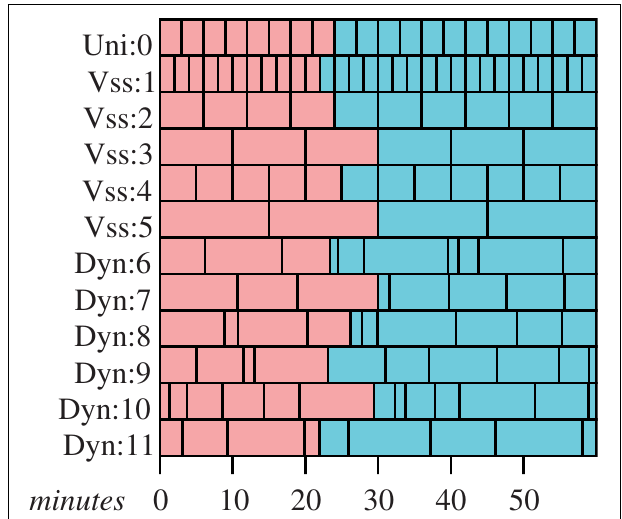
FIGURE 1 | Time scheduling strategies. Red boxes represent time steps that have already passed, blue boxes represents scheduled time steps that have not yet been run. “Uni:” and “Vss:” submodels are members of a uniform or variable speed splitting submodels and require uniform time steps, and “Dyn:” submodels have adaptive time